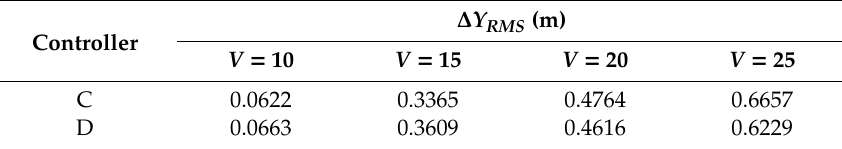
Figure 11. Slip angle at different vehicle velocities. ( a ) 10 m/s; ( b ) 15 m/s; ( c ) 20 m/s; ( d ) 25 m/s. Table 7. Lateral deviations of 2 controllers at di ff erent vehicle velocities V (m / s).